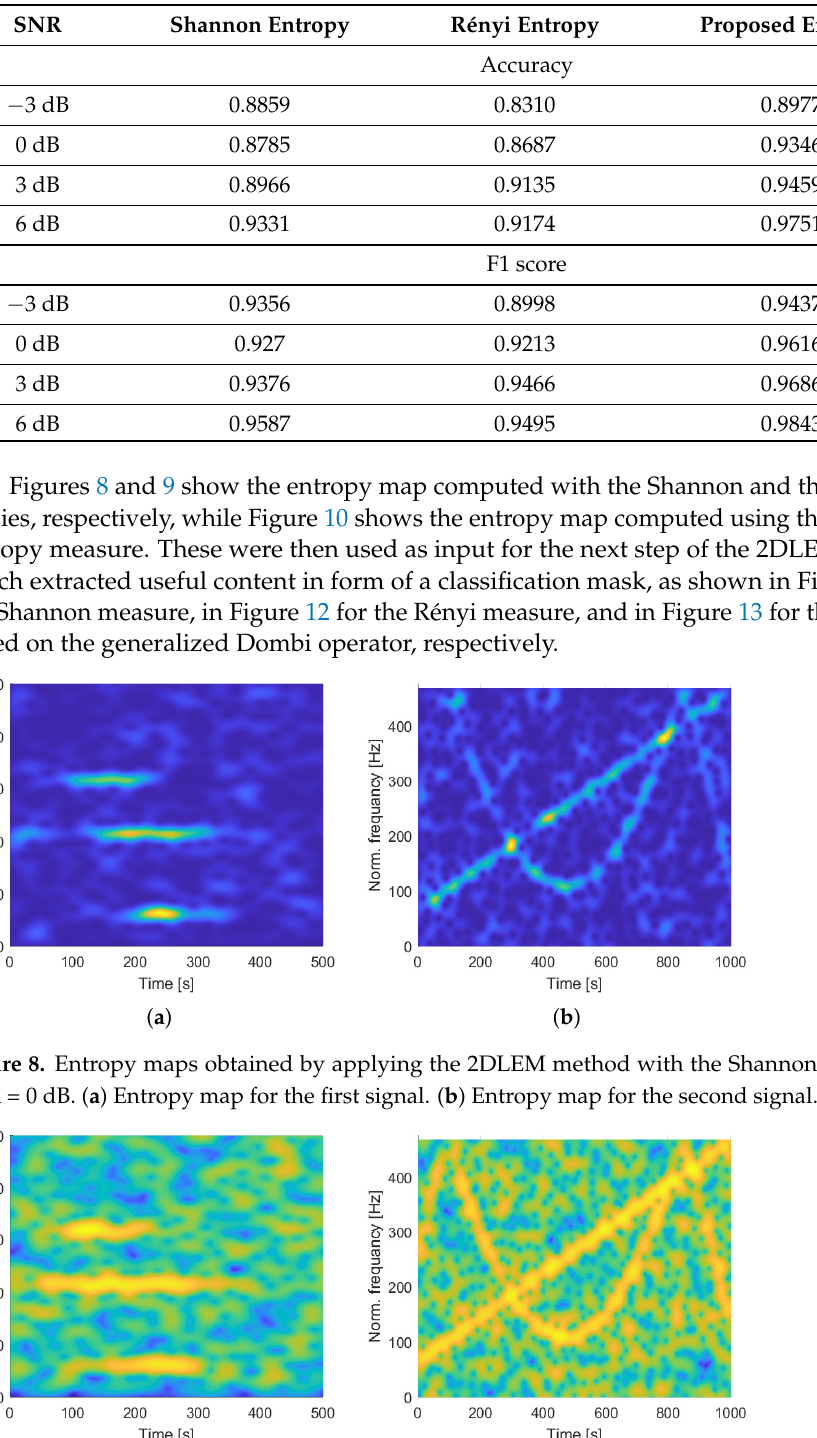
Table 7. Classification results for the second signal.